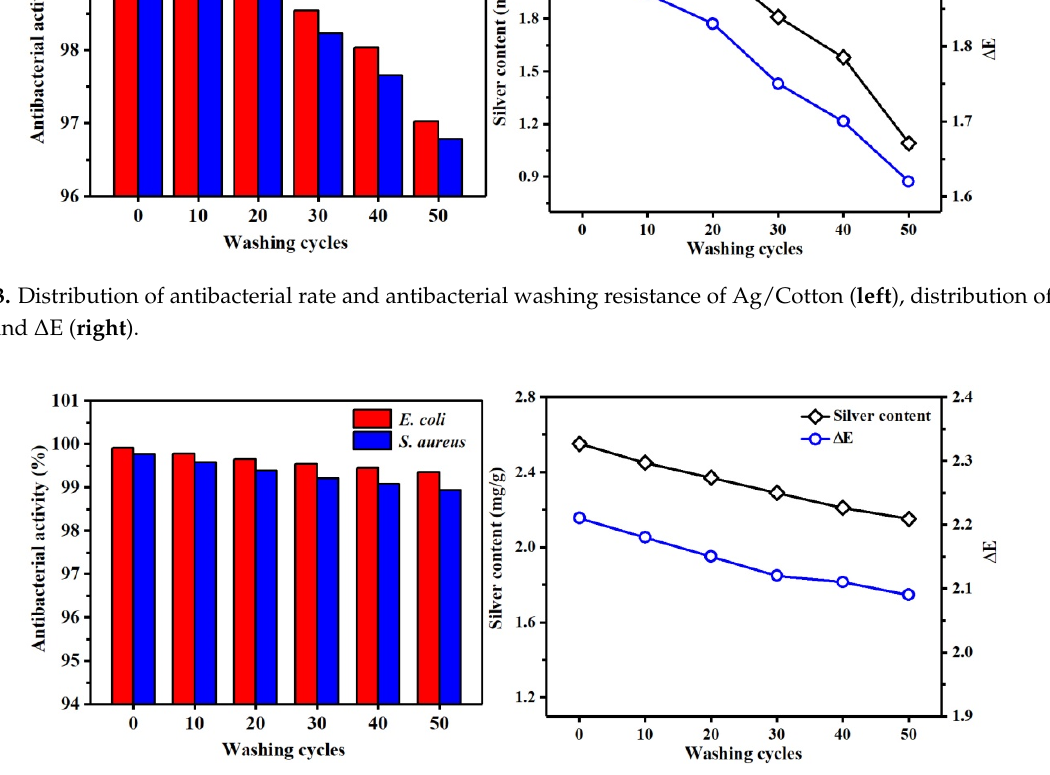
Figure 14. Distribution of antibacterial rate and antibacterial washing resistance of PMA-CA-Ag/Cotton ( left ); distribution of silver content and ∆ E ( right ).